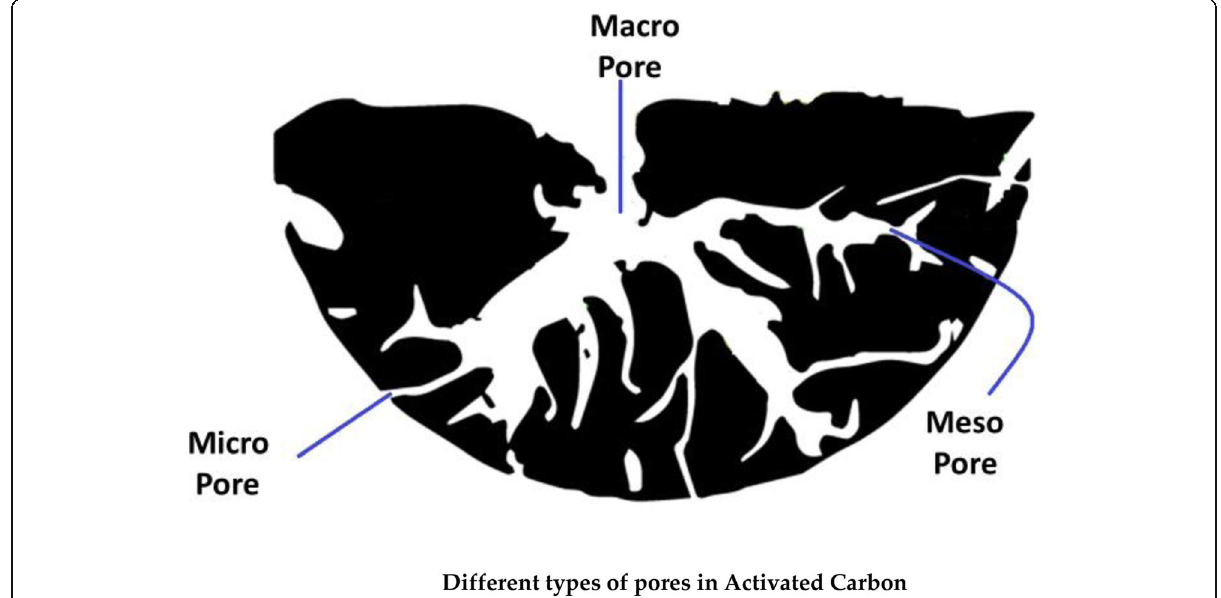
Fig. 6 Different types of pores in activated